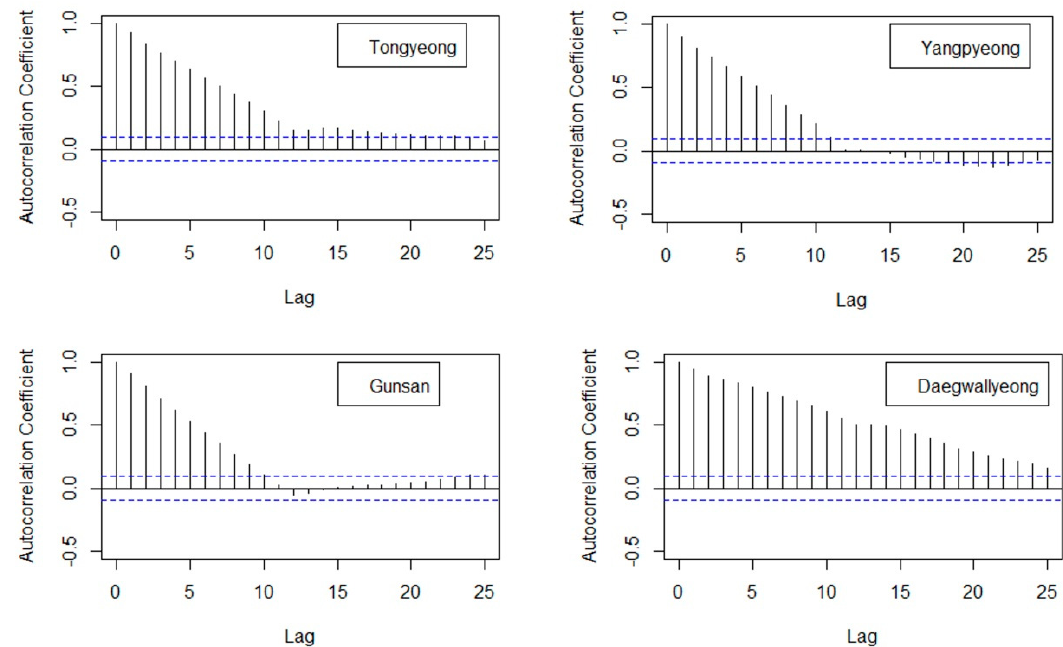
Figure 9. Autocorrelation coefficients of the SPI-12 for the four representative meteorological stations at a critical value α = 0.05.